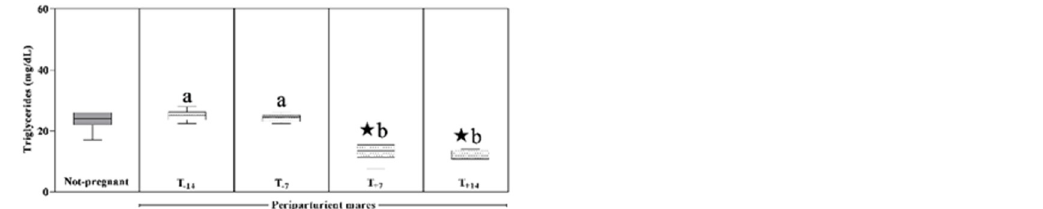
Figure 2. Mean values ± standard deviation (SD) of serum leptin, mitochondrial uncoupling protein 1 (UCP1), non-esterified fatty acids (NEFAs), total cholesterol, high-density lipoproteins (HDLs), low-density lipoproteins (LDLs) and triglycerides obtained in periparturient mares (Group A) and non-pregnant group (Group B) with the relative statistical significances. The symbol “star” ( (cid:70) ) reflects difference significant differences between groups, vs. non-pregnant mares ( p < 0.0001); different alphabetic letters show significant differences within peripartum period ( p < 0.0001).